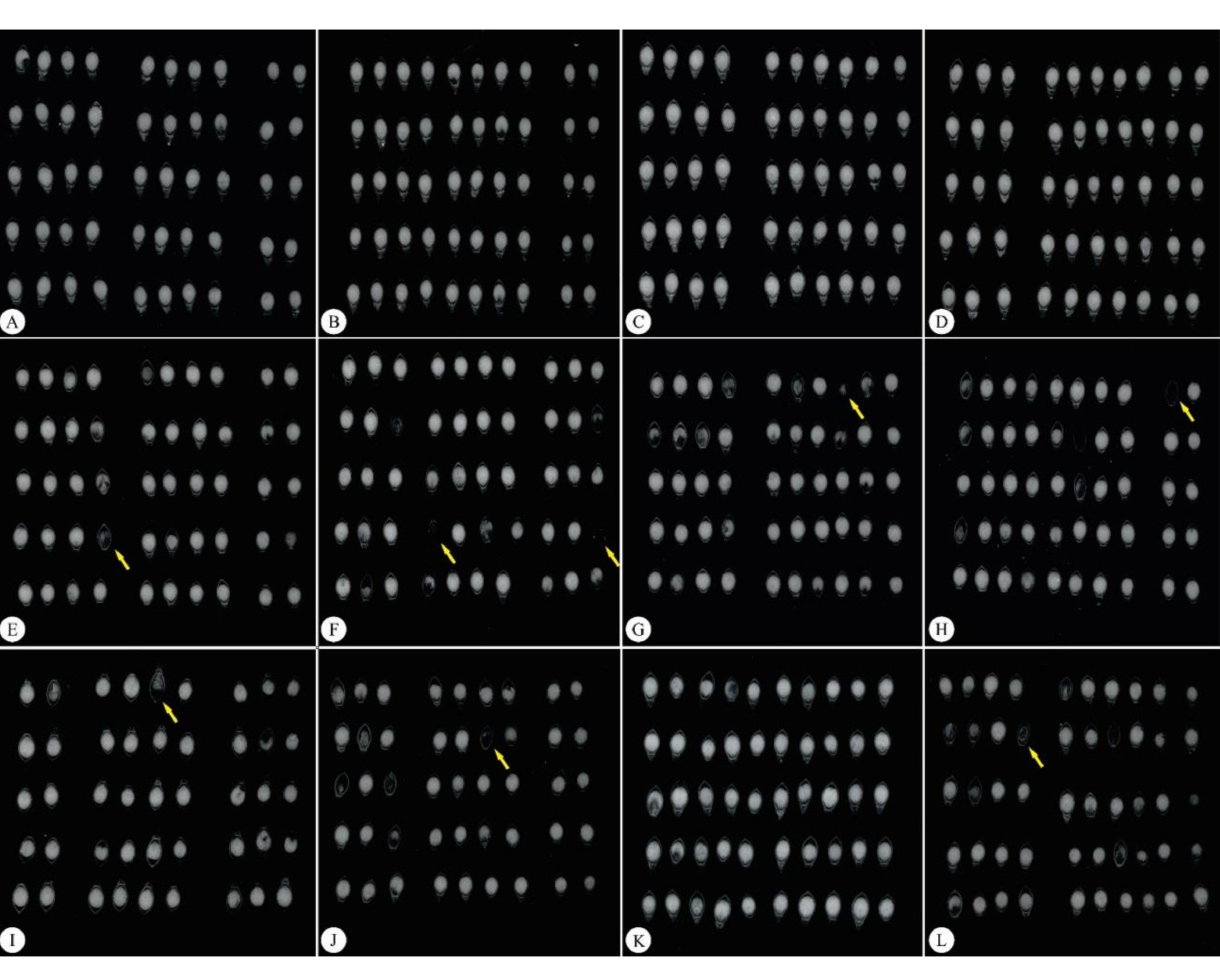
Figure 1. Differences in internal Brachiaria brizantha seed structures demonstrated by X-ray